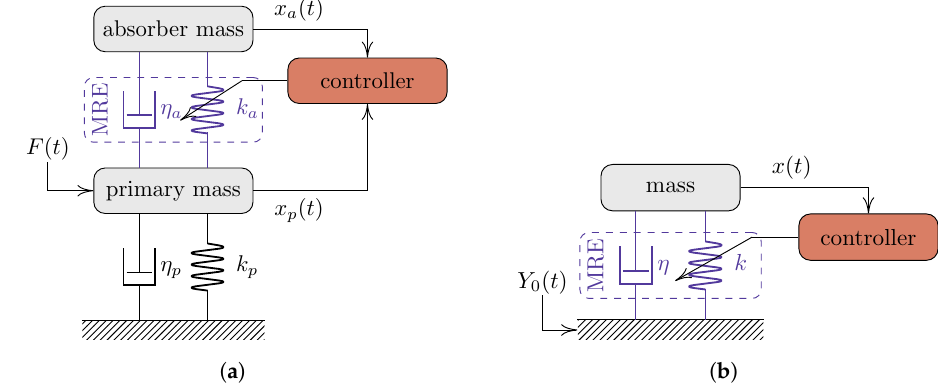
Figure 9. The schema of typical vibration control systems. The vibration absorber ( a ). The vibration isolator ( b ).